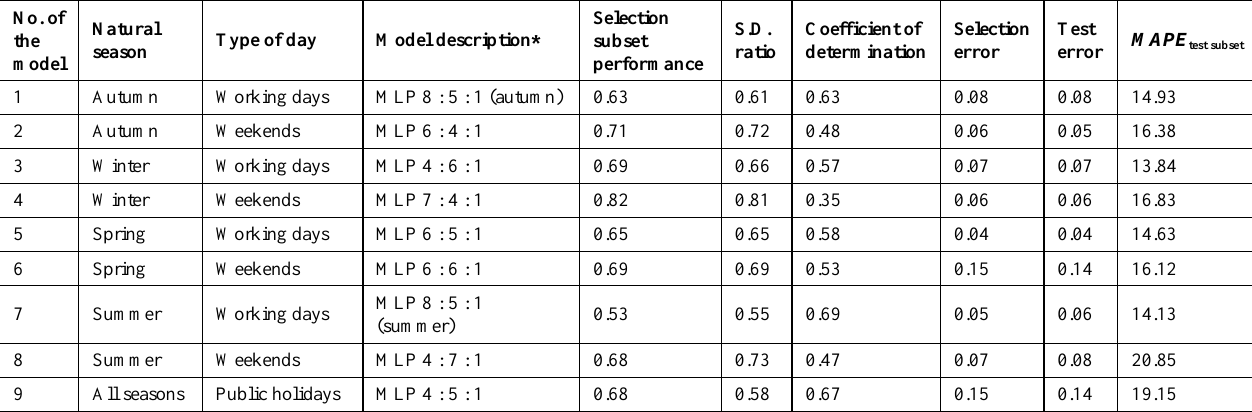
P ARAMETERS OF THE M ODELS OF E LECTRICITY P RICE E XPECTATIONS (C ALCULATIONS M ADE BY THE A UTHORS ) No. of the